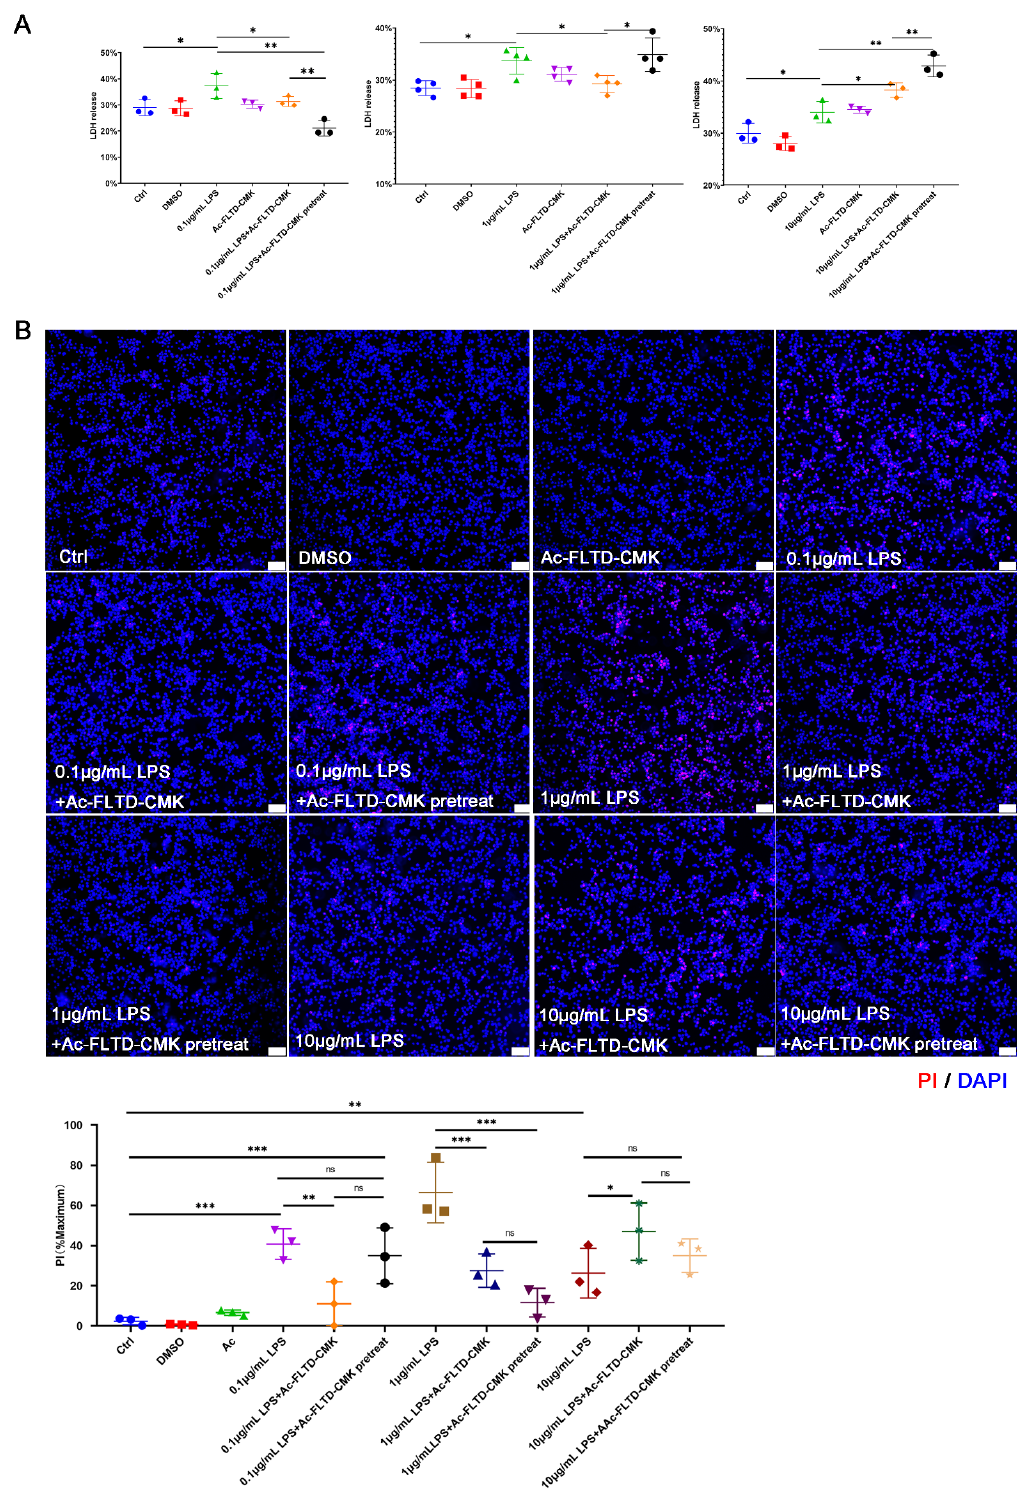
Figure 6. LDH release and PI staining in macrophages stimulated with different levels of LPS and different inhibition durations of Ac-FLTD-CMK. THP-derived macrophages were serum-starved and then stimulated with 0.1 µ g/mL~10 µ g/mL LPS for 6 h, with no pretreatment or pretreatment with Ac-FLTD-CMK. ( A ) LDH release from THP cells was detected. ( B ) PI staining was quantified by ImageJ software. (one-way ANOVA, n = 3~4; *, p < 0.05, **, p < 0.01; ***, p < 0.001; ns, no